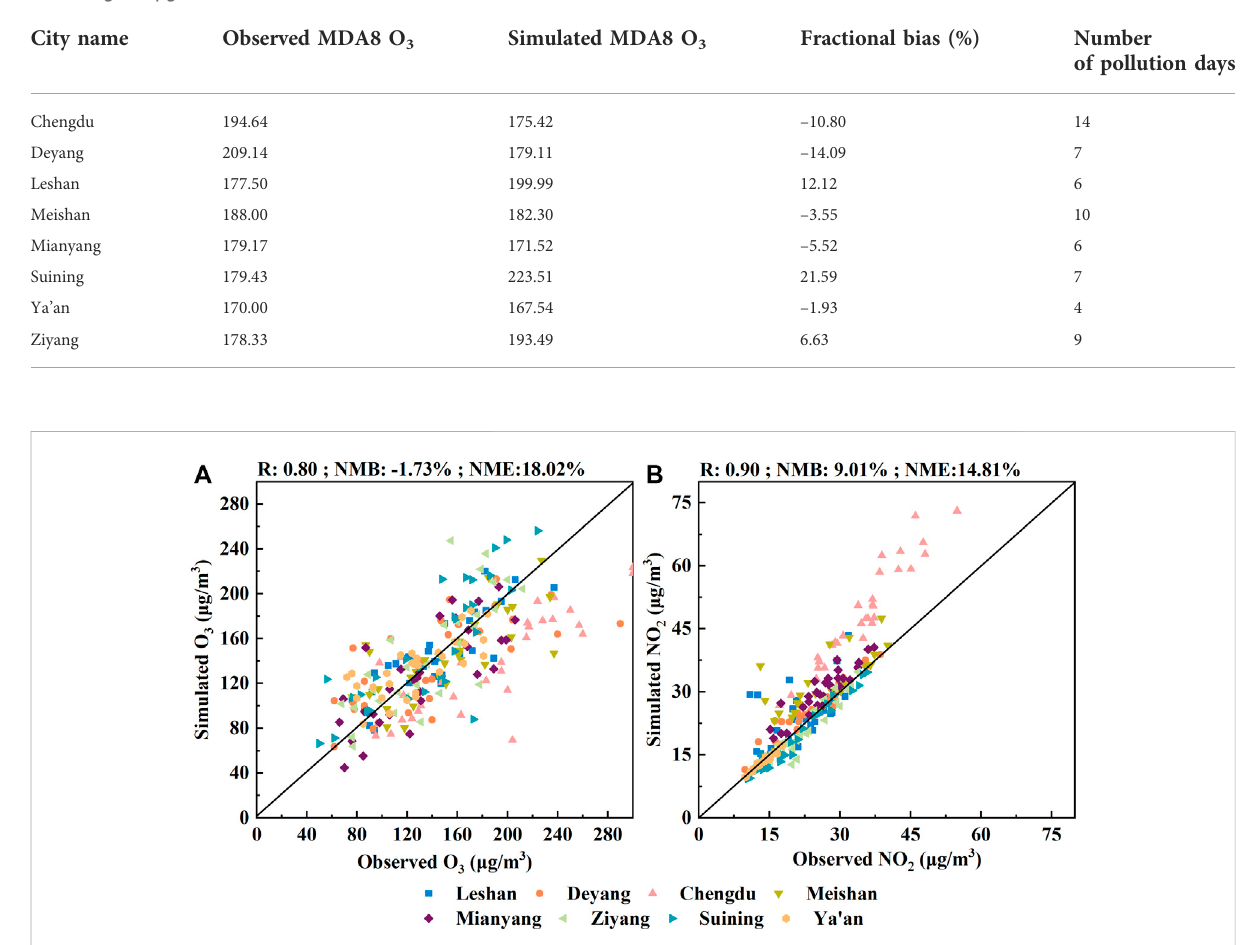
TABLE 1 Comparisons of observed and simulated MDA8 O 3 concentrations on polluted days in eight cities in August 2019 (MDA8 O 3 concentrations exceeding 160 μ g m − 3